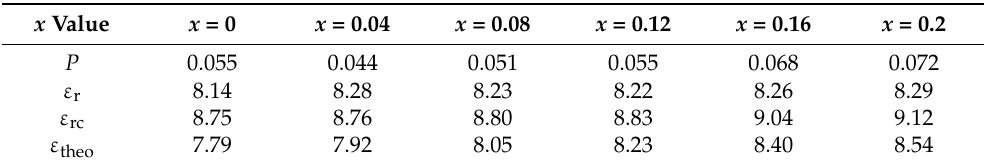
Table 3. Measured dielectric constant ( ε r ) and porosity-corrected dielectric constant ( ε rc ) of Mg 1 − x Cu x Al 2 O 4 ceramics sintered at 1550 ◦ C.